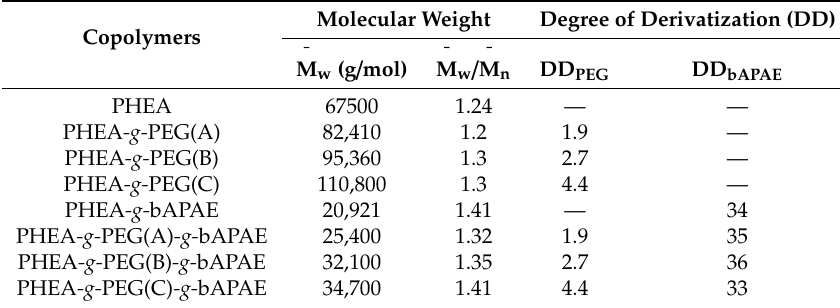
Table 2. Weight-average molecular weight (M w ), polydispersity index (M w /M n ) , and chemical composition of obtained